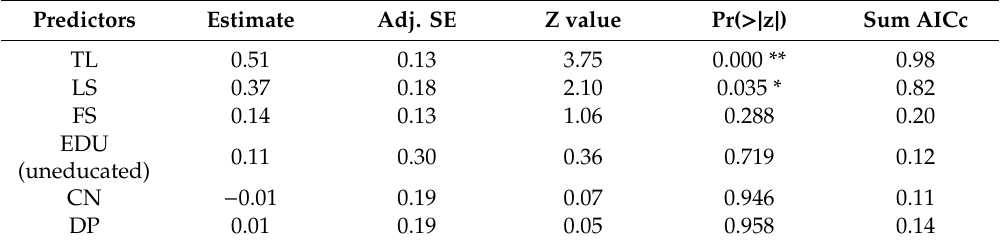
Table 4. Model averaging and results from 95% confidence interval for livestock loss due to snow leopards; Relative importance (sum AICc) of the predictors were obtained for models whose delta AICc was less than 7. TL = total number of livestock owned, LS = number of larger bodied livestock owned, DP = days livestock housed in pastures, CN = number of corrals, FS = family size and EDU = education status of the